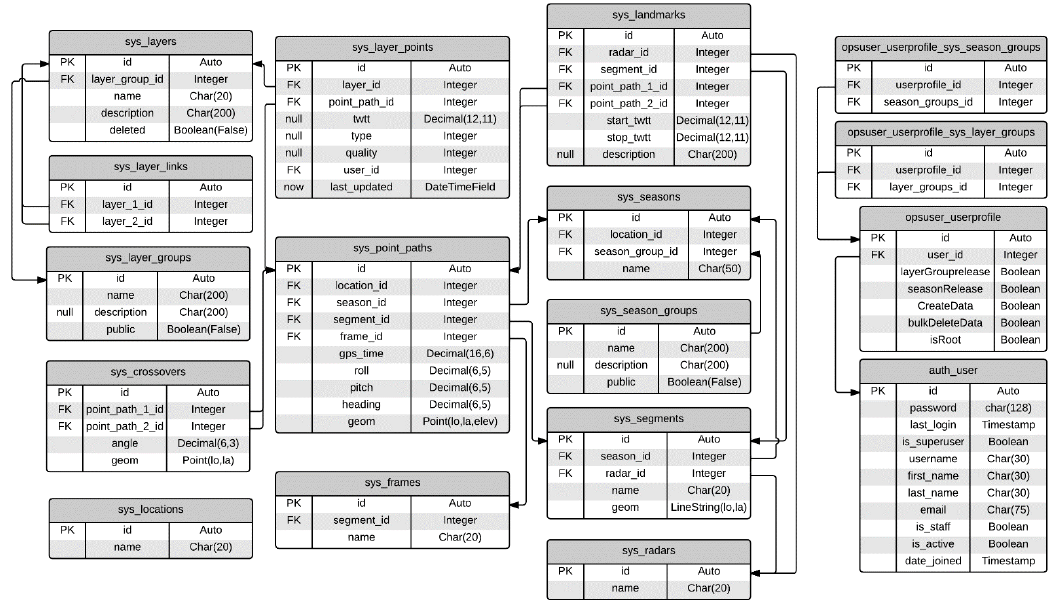
Figure 5. Entity-relationship diagram of the OPS spatial database.